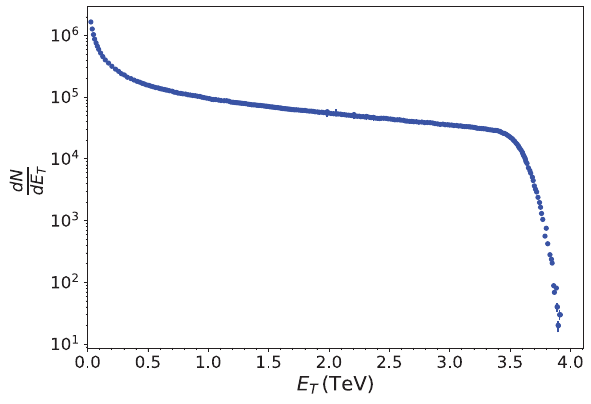
Figure 1. The transverse energy distribition for Pb-Pb collisions at centre of mass energy 2 . 76 TeV per nucleon. The data here is in the pseudorapidity range of 3 . 2 < | η | < 4 . 9, and is taken from the ATLAS collaboration